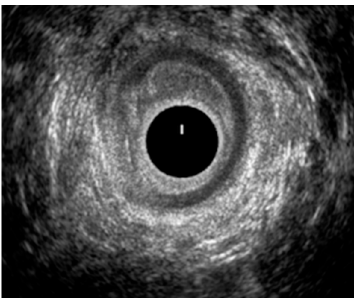
Figure 1. Laceration of the internal anal sphincter from 3 to 9 o’clock (left, posterior, right quadrant) in the middle anal canal. Transphincteric fistula with a seton in place, at 4 − 5 o ′ clock (left quadrant).